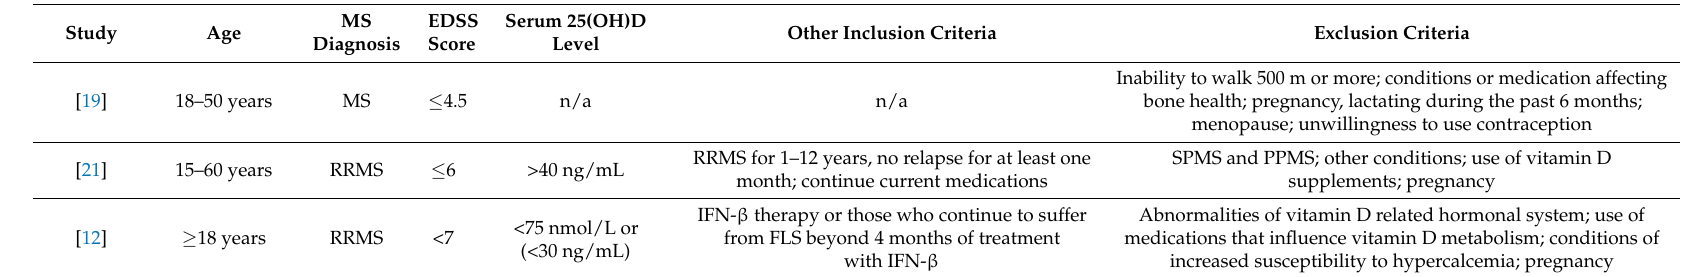
Table 3. Inclusion and exclusion criteria of reviewed